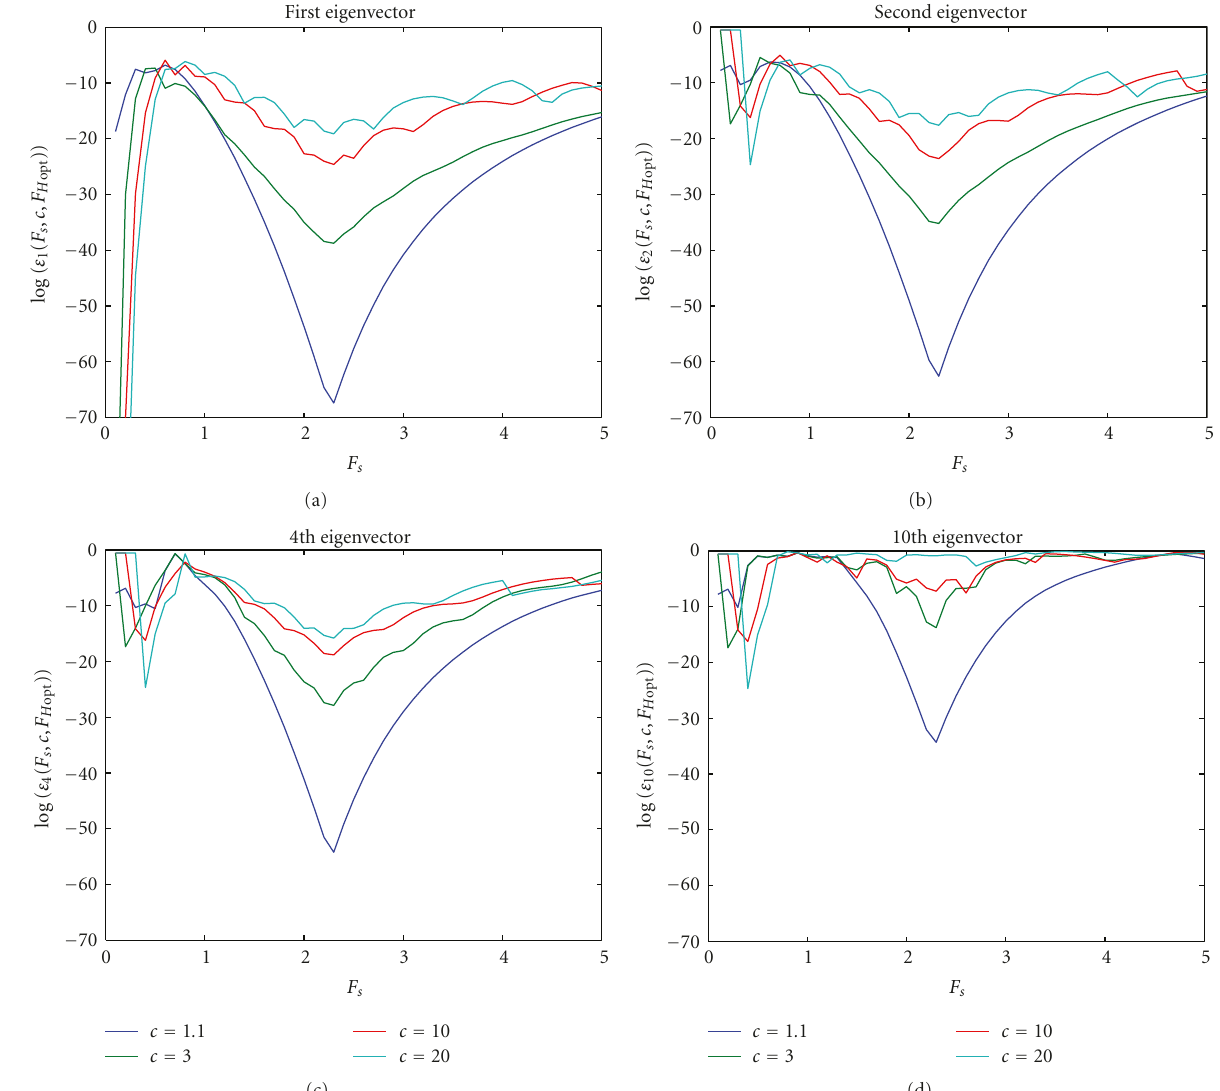
Figure 6: The dependence on F s of the errors between the eigenvector optimal to LSP and the corresponding hermite function for di ff erent c -values. The 1st, 2nd, 4th, and 10th eigenvector are compared. The eigenvector length is N = 32.